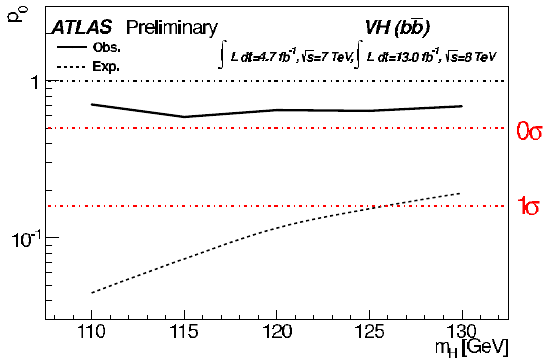
Figure 5. The observed probability, p 0 , in the background-only scenario (solid line) as a function of m H [9]. The dashed line shows the corresponding expectation for the signal + background hypothesis at the given value of m H